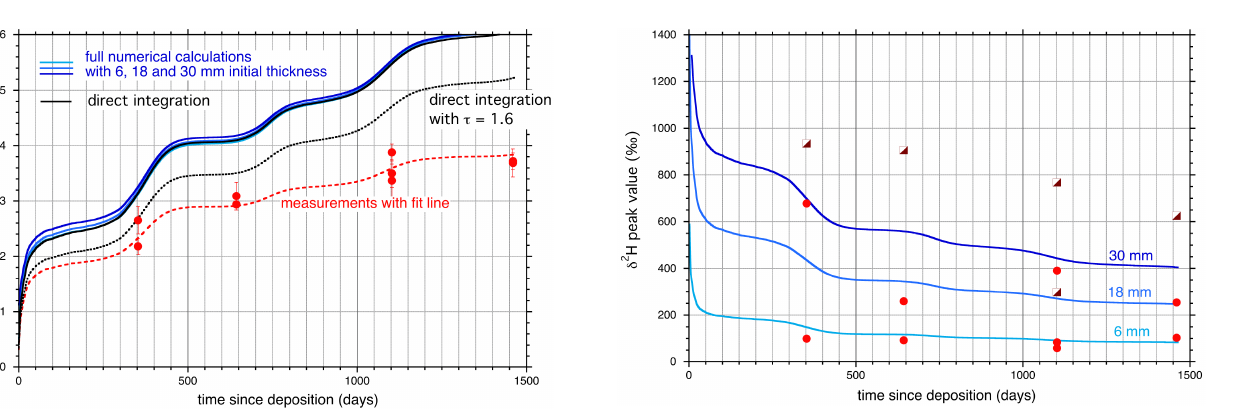
Figure 7. The results for the diffusion length σ . The points are the experimental results. The set of four higher-lying curves (one black, three in shades of blue) is the result of the numerical simulation us- ing the Johnsen et al. (2000) model. The black one is the direct calculation of σ ; the three blue ones result from the full numeri- cal procedure starting with an enriched layer with 6, 18 and 30mm initial thickness. Clearly, there is a systematic mismatch between the experimental results and the numerical simulations, increasing with time. The fit curve through the measurements is constructed by lowering the diffusivity by 25% in the first year, up to 40% in the last. Finally, the black dotted line shows the numerical result using a fixed, higher value for τ (1.6).